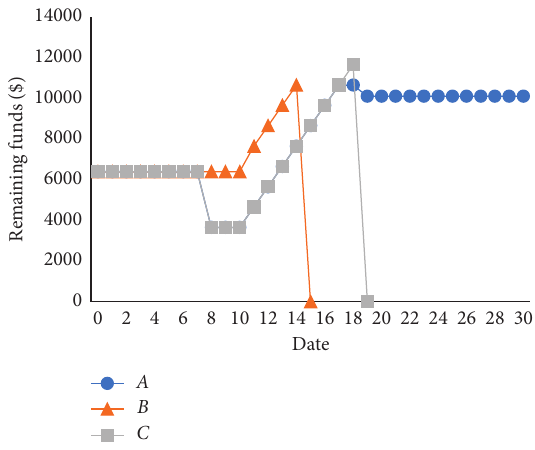
Figure 13: Comparison of remaining funds.